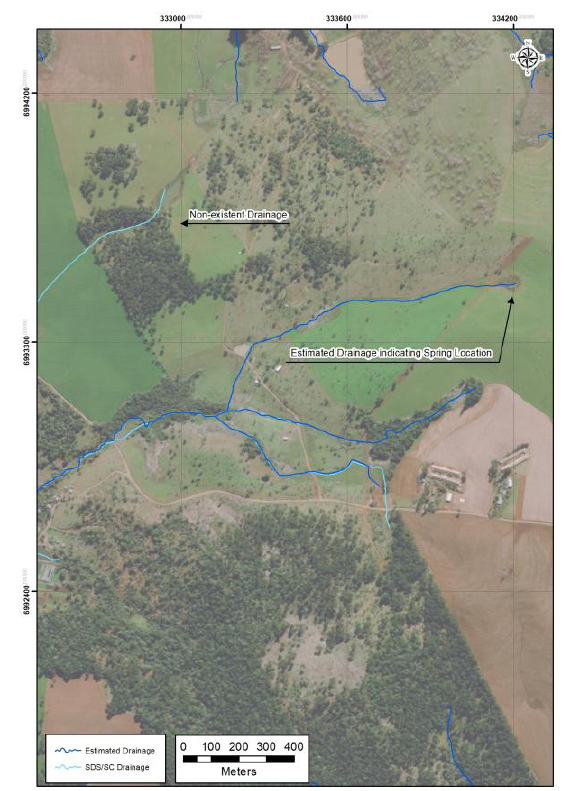
Figure 4 – Estimated Drainage overlaying SDS/SC drainage. Arrows indicate differences existent in these two datasets.